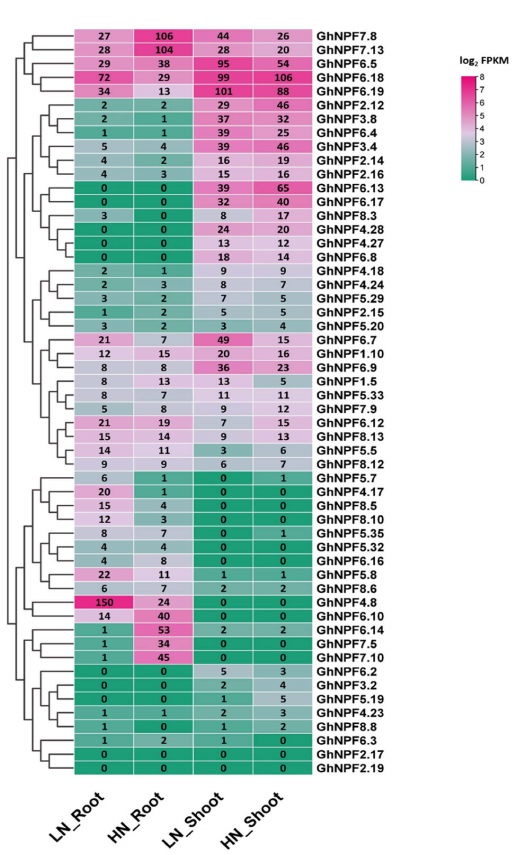
Figure 5. Expression profiles of 54 GhNPF family genes under N deficiency treatments. The expression data were obtained from RNA-seq data and shown as log 2 FPKM